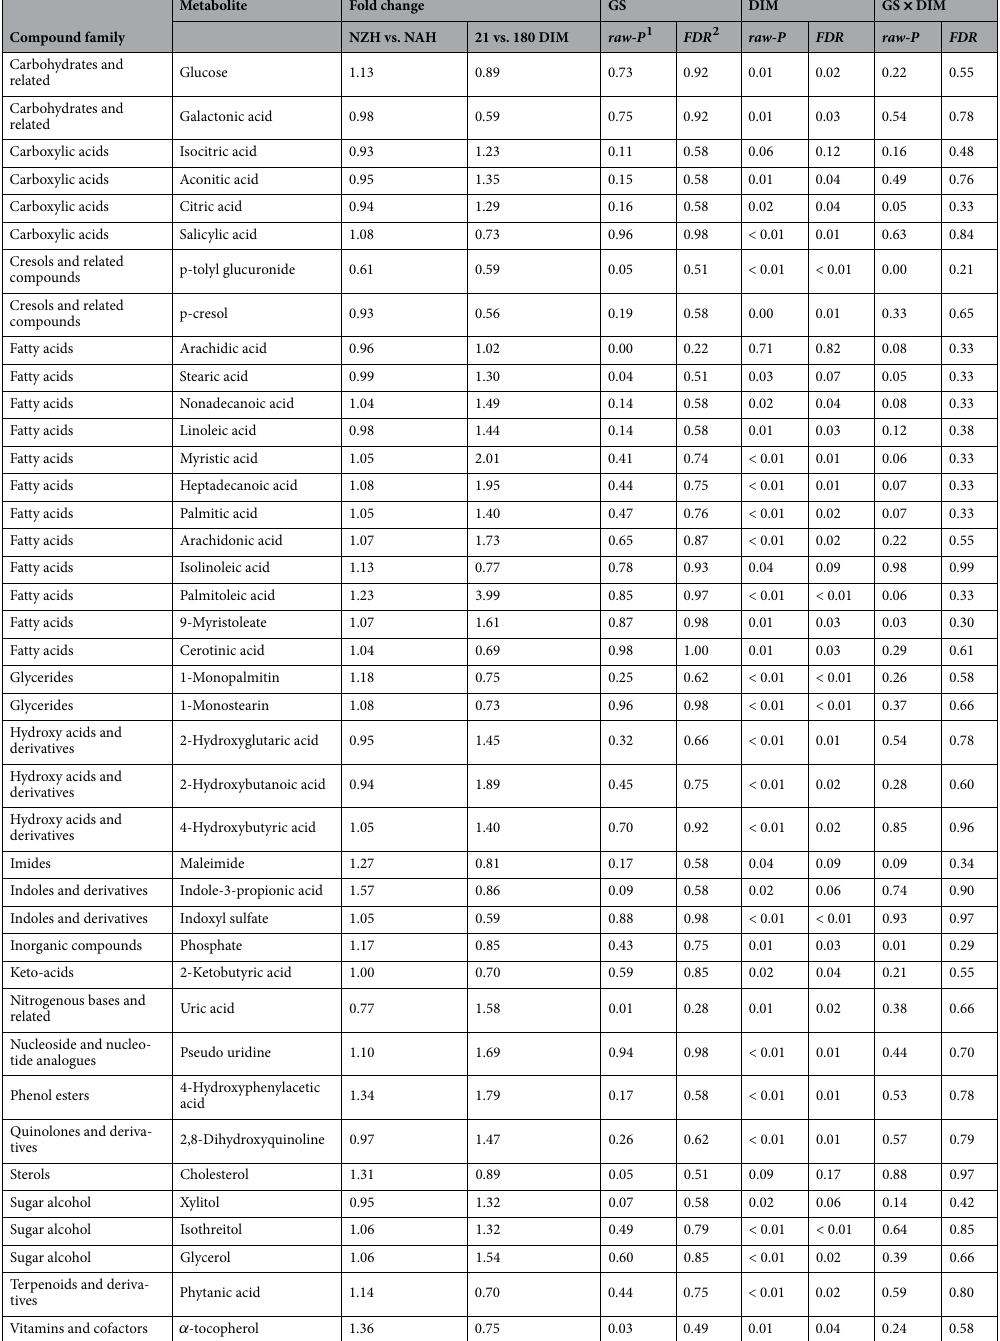
Table 2. Fold change and ANOVA fixed effects statistics of plasma metabolites determined by metabolomics and differing between genetic strains (GS; North American Holstein, NAH, n = 8; New Zealand, NZH, n = 8), days in milk (DIM; 21 vs. 180 DIM) or due to the interaction between genetic strains and days in milk. 1: raw- P value according to ANOVA; 2: P -value adjusted by false discovery